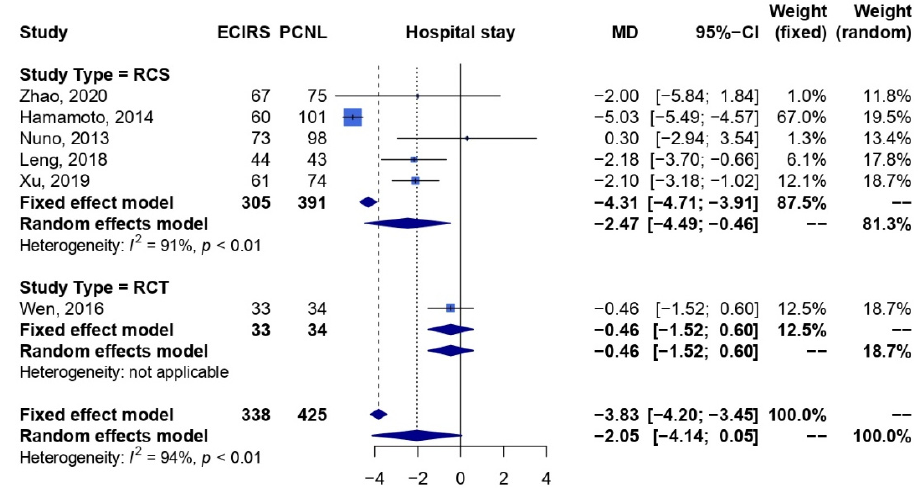
Figure A17. Subgroup analysis of outcome regarding operative time . (RCS: [18.19,21,22,23]; RCT: